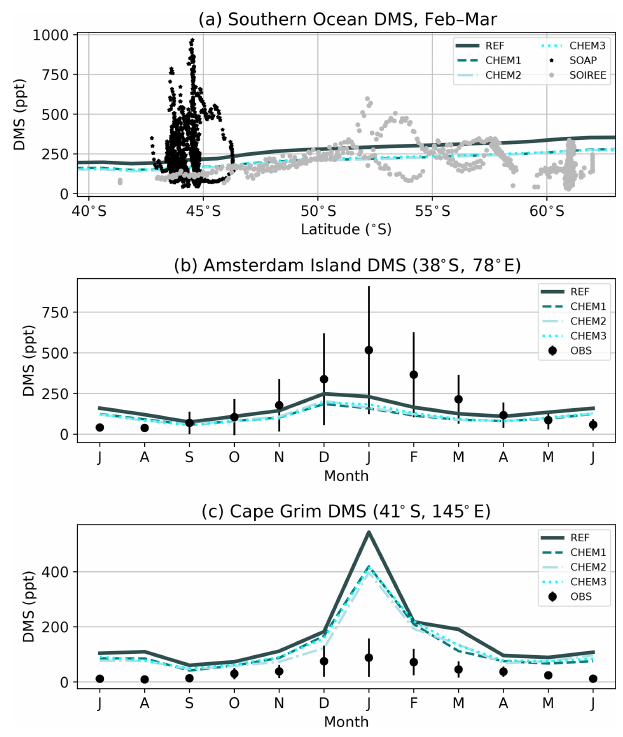
Figure 6. (a) DMS measurements obtained from the Surface Ocean Aerosol Production campaign (SOAP) and the Southern Ocean Iron Release Experiment (SOIREE), compared to simulated surface at- mospheric DMS concentrations from the REF, CHEM1, CHEM2 and CHEM3 simulations. Model data are averaged over the com- bined domain of both voyages (172–180 ◦ E) and show February– March climatological means calculated over the period 1989–2008. (b) Climatological monthly-mean surface atmospheric DMS mea- sured at Amsterdam Island between 1987 and 2008 compared to simulated surface atmospheric DMS concentrations at Amsterdam Island in the REF and CHEM simulations. The error bars show the standard deviation on the observed monthly mean. (c) As for panel (b) but showing DMS at Cape Grim between 1989 and